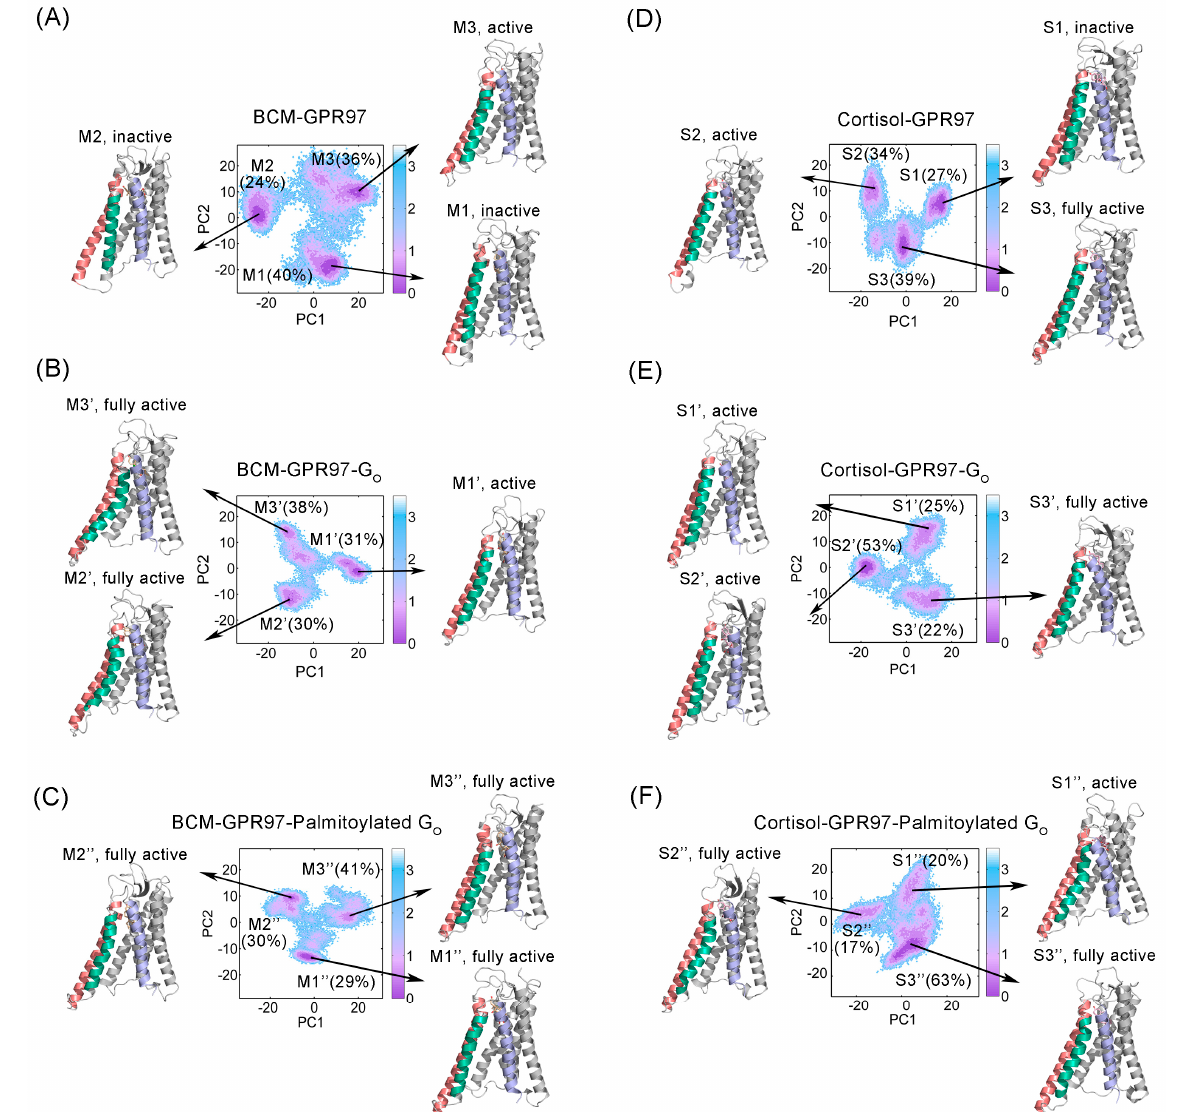
Figure 5. Projection of dominant metastates extracted from MSMs onto the GPR97 conformational landscape of BCM–GPR97 ( A ), BCM–GPR97–G o ( B ), BCM–GPR97–palmitoylated G o ( C ), cortisol– GPR97 ( D ), cortisol–GPR97–G o ( E ), and cortisol–GPR97–palmitoylated G o ( F ) systems generated using PCA. The representative GPR97 structure substates in BCM–GPR97 (M1, M2, and M3), BCM–GPR97–G o (M1 ′ , M2 ′ , and M3 ′ ), BCM–GPR97–palmitoylated G o (M1 ″ , M2 ″ , and M3 ″ ), cortisol– GPR97 (S1, S2, and S3), cortisol–GPR97–G o (S1 ′ , S2 ′ , and S3 ′ ), and cortisol–GPR97– palmitoylated G o (S1 ″ , S2 ″ , and S3 ″ ), along with their probabilities, are shown, with the TM5, TM6, and TM7 regions colored red, green, and purple, respectively.